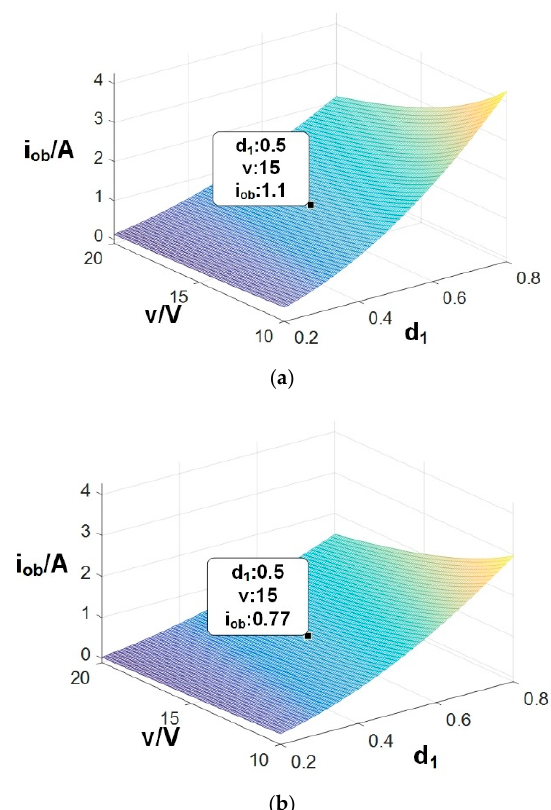
Figure 10. The observed current values based on different observers. ( a ) ACO, ( b ) DACO.